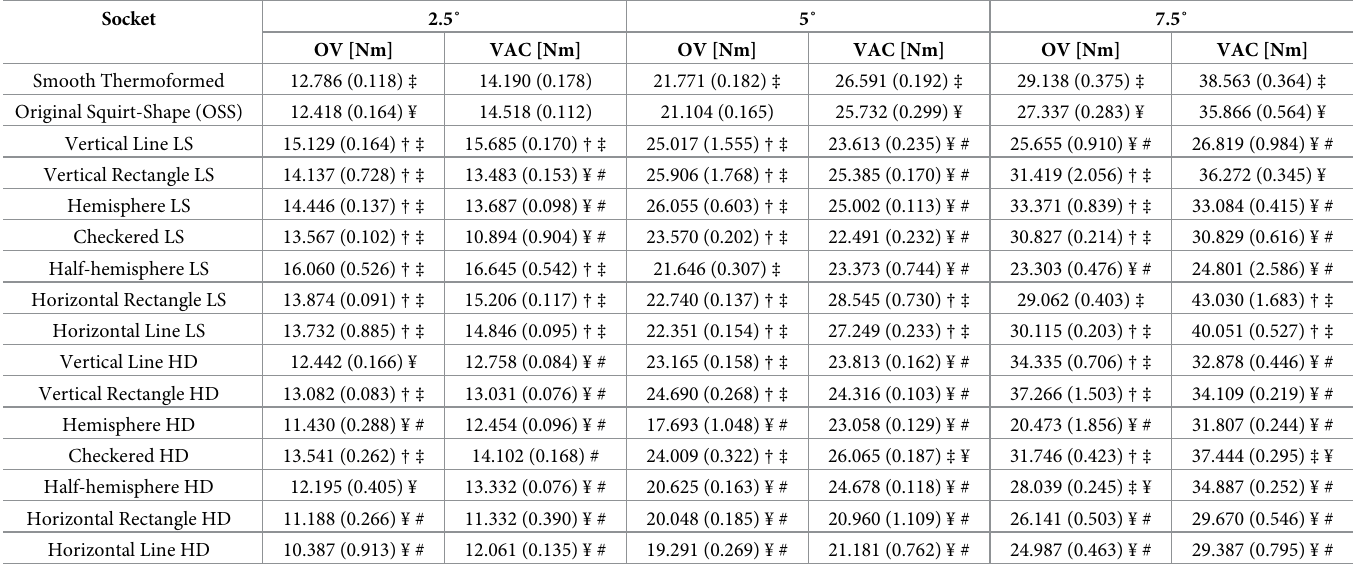
Table 1. Absolute Mean and Standard Deviation (SD) for torque at each rotation angle for both suspension conditions (OV: Passive suction with one-way valve; VAC: Active vacuum suspension at 20 inHg (67.73 kPa); Nm: Newton meter; LS: Light and sparse; HD: Heavy and